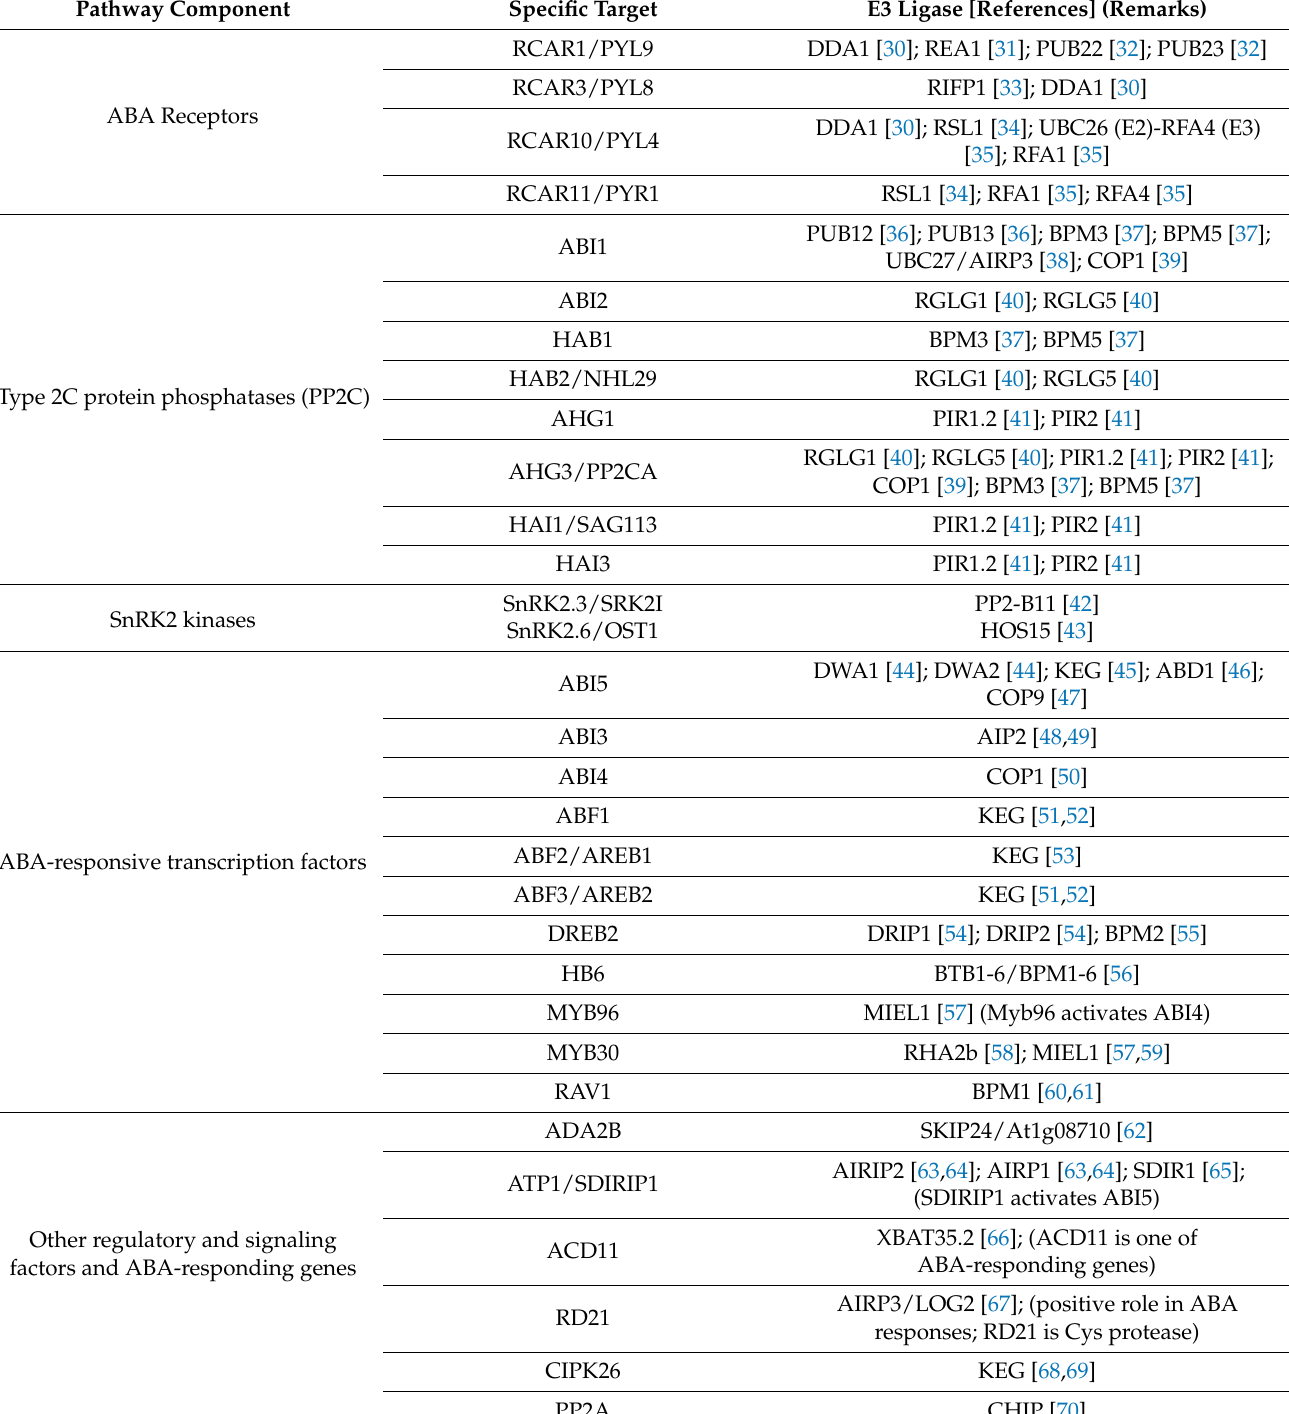
Table 1. ABA pathway components targeted by E3